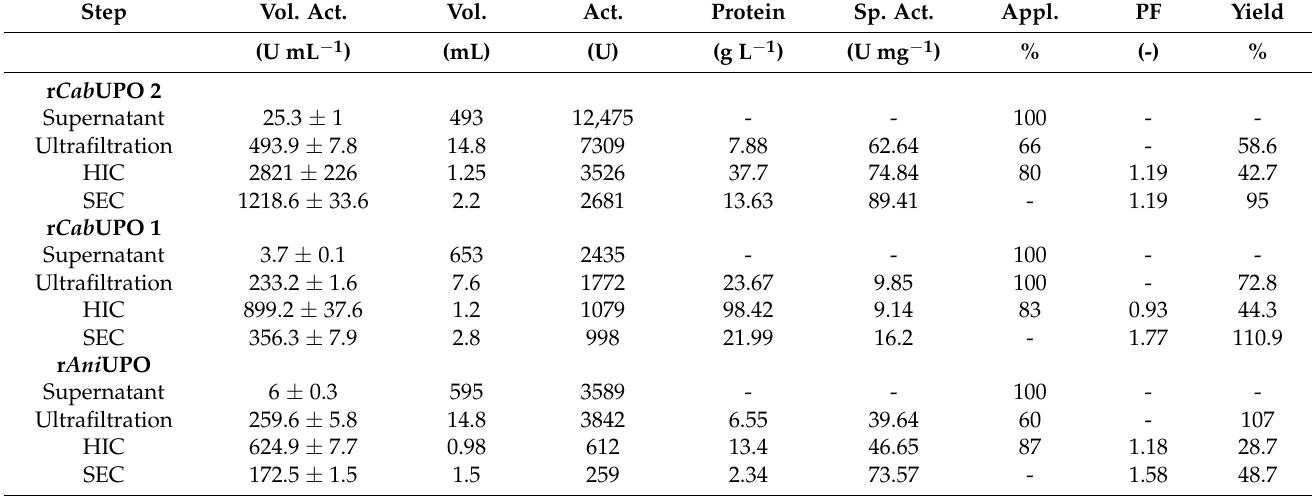
Table 2. Purification of r Cab UPO 1, r Cab UPO 2, and r Ani UPO. Supernatant refers to culture